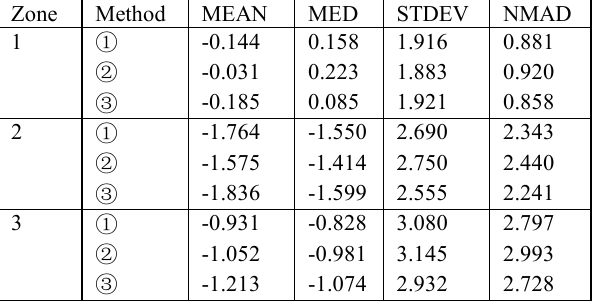
Table 3 DSM error statistical results of artificial buildings and weak texture areas in Pleiades image obtained by three